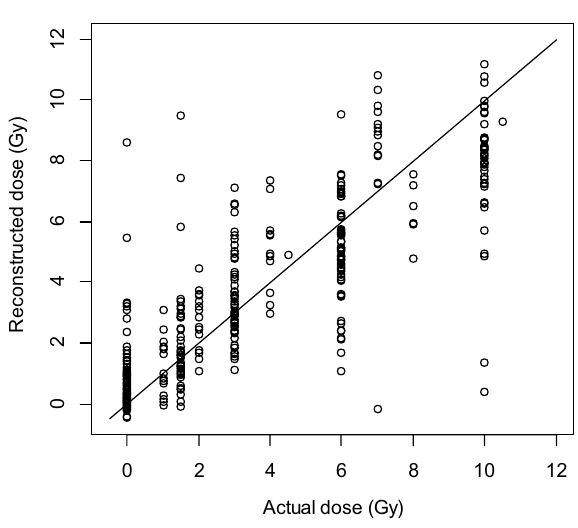
Figure 3. Dose reconstruction based on mouse microarray data analyzed using a nonlinear model Eq. (1). The model was based on the net gene signal (difference between median signals of the gene groups with positive and negative correlations with radiation dose), and time (days) after irradiation. The best-fit parameter values for this dose reconstruction model were: k 1 = 0.906 (standard error SE = 0.086, p value = < 2 × 10 –16 ) Gy −1 , k 2 = 0.274 (SE = 0.028, p value = < 2 × 10 –16 ) Gy −2 , k 3 = 0.549 (SE = 0.069, p value = 1.5 × 10 –14 ) days −1/2